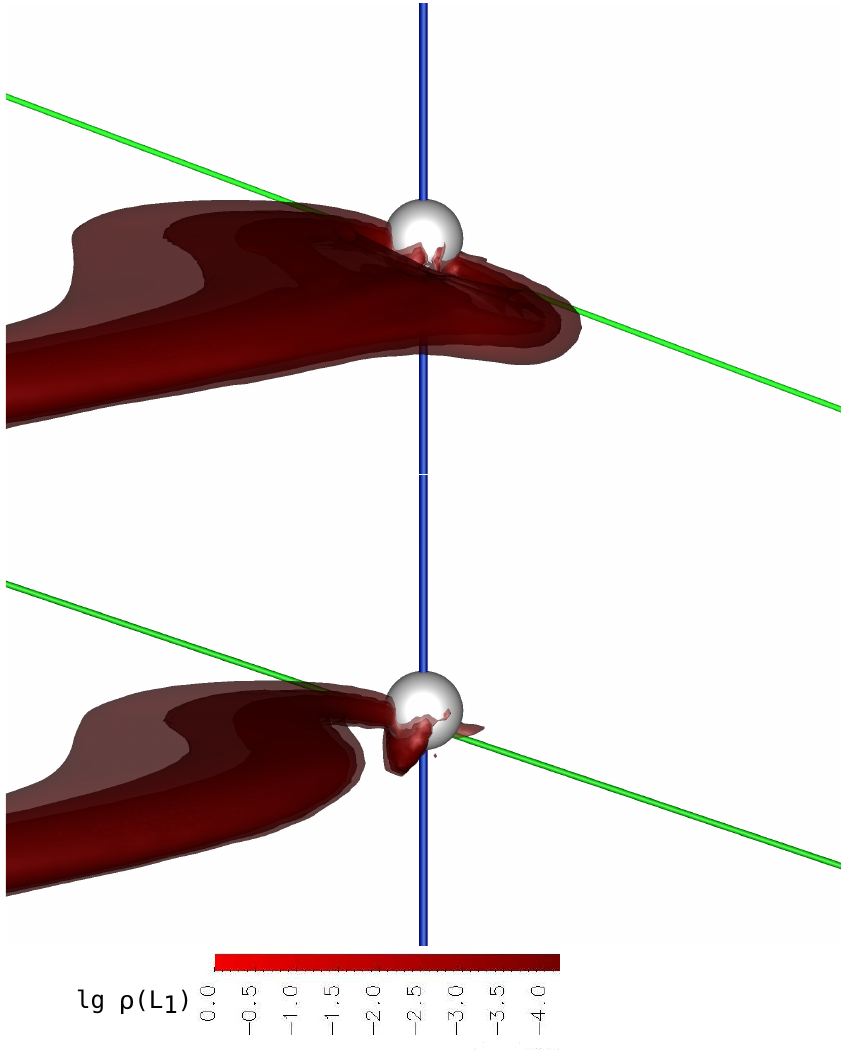
Figure 12. The same as in Figure 11 but for Phase 3 ( upper panel)) and Phase 4 ( lower